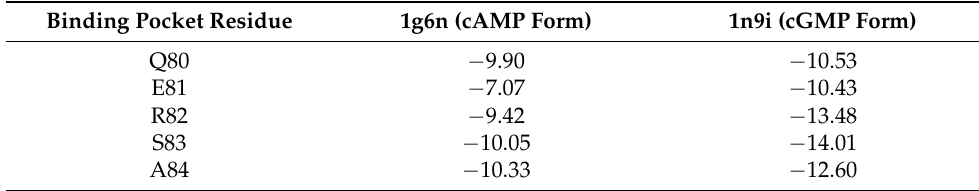
Table 2. The docking parameters.